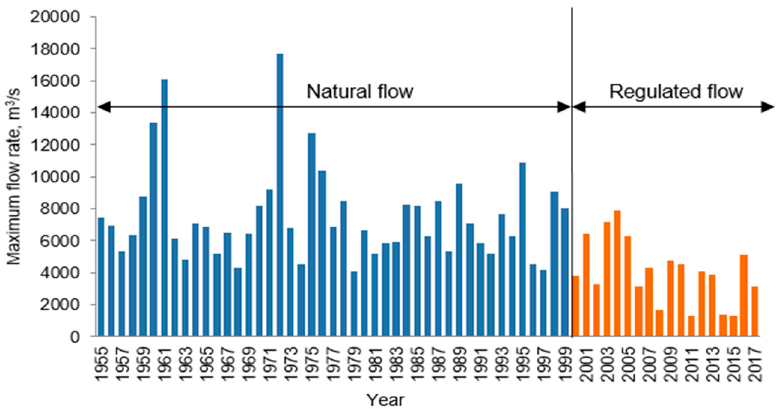
Figure 4. Maximum levels of the Bureya River at the Malinovka stream gauge decreased due to flow regulation by dams.